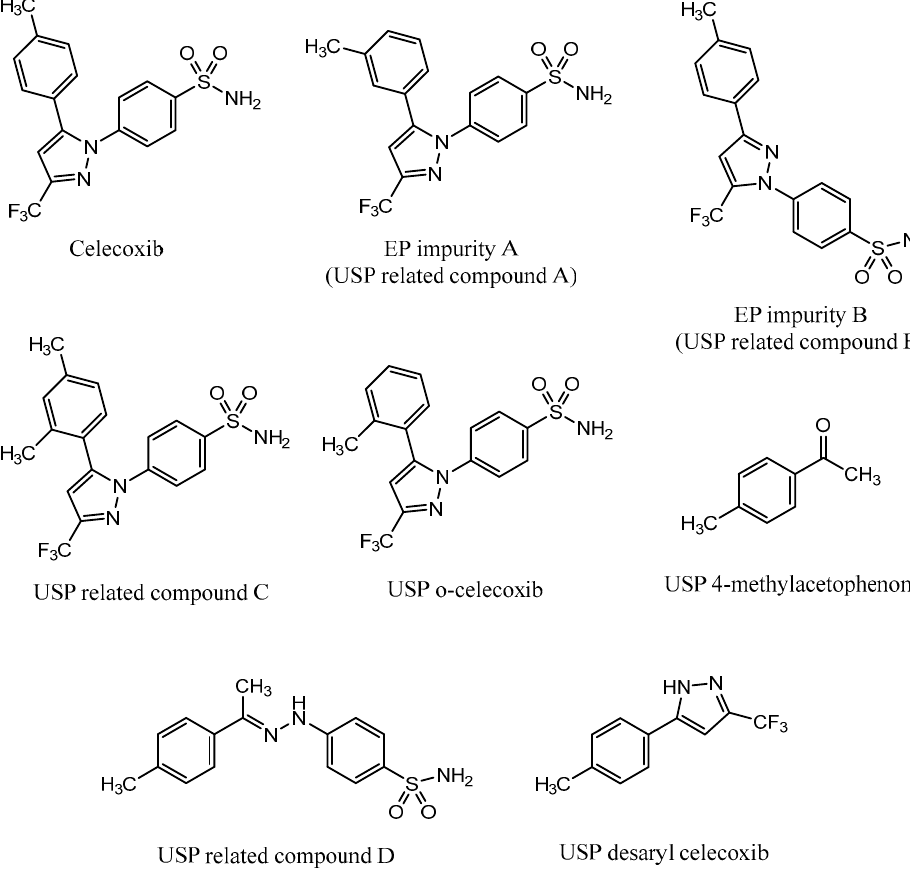
Figure 1. Structure of celecoxib and its process-related impurities defined in European Pharmacopeia (EP) [23] and United States Pharmacopeia (USP) [24,25].